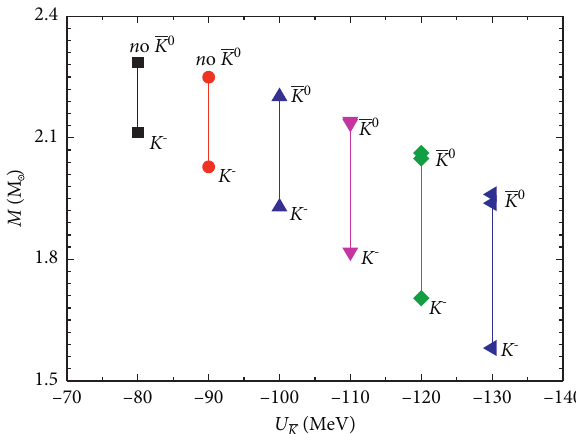
Figure 1: Mass ranges of NSs including antikaon condensations as a function of the optical potential of antikaons U − 130MeV.